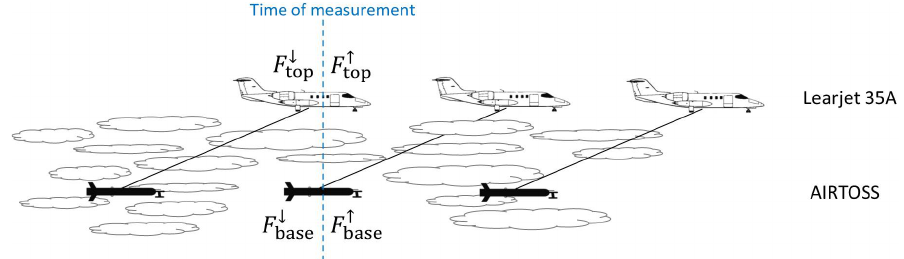
Figure 3. Schematic sketch of measurement setup to measure collocated upward ( F ↑ ) and downward ( F ↓ ) irradiance at two altitudes (base,